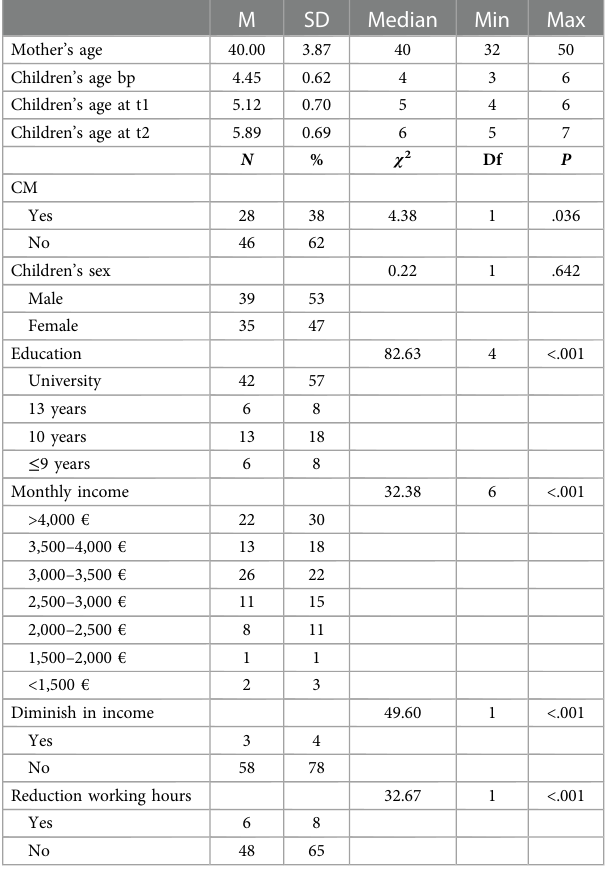
TABLE 1 Descriptive data and results of χ 2 -tests.